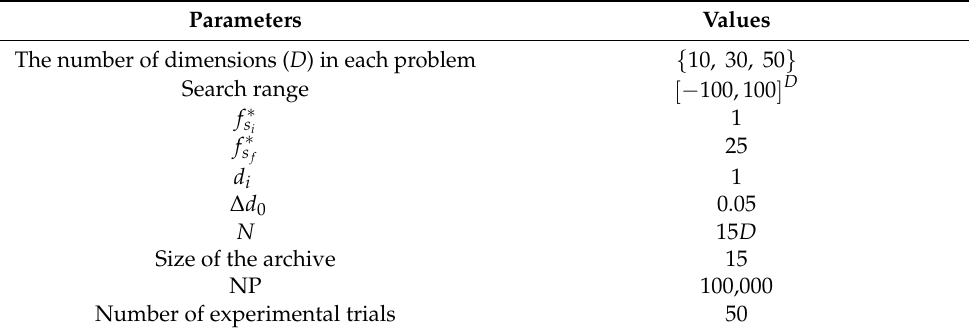
Table 1. The parameters of the proposed algorithm experiment. Parameters